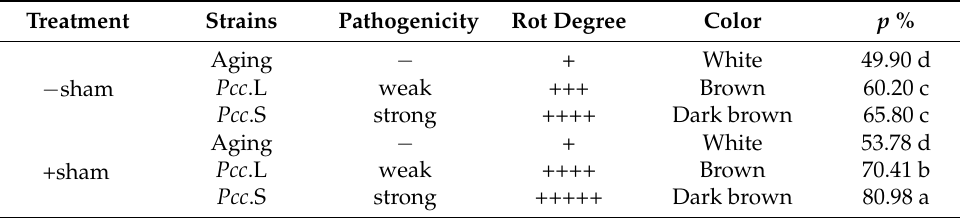
Figure 1. The effect of Pcc .L and Pcc .S treatments on the infection degree of potato tuber slices. “L” and “S” indicate pathogenic bacteria of Pcc .L and Pcc .S, respectively. “2, 6, 12” indicate post-inoculation time (h). “+” and “ − ” indicate salicylhydroxamic acid pretreatment and without salicylhydroxamic acid treatment, respectively. Table 1. The change of potato tuber slices after inoculation with Pcc .L and Pcc .S on 12